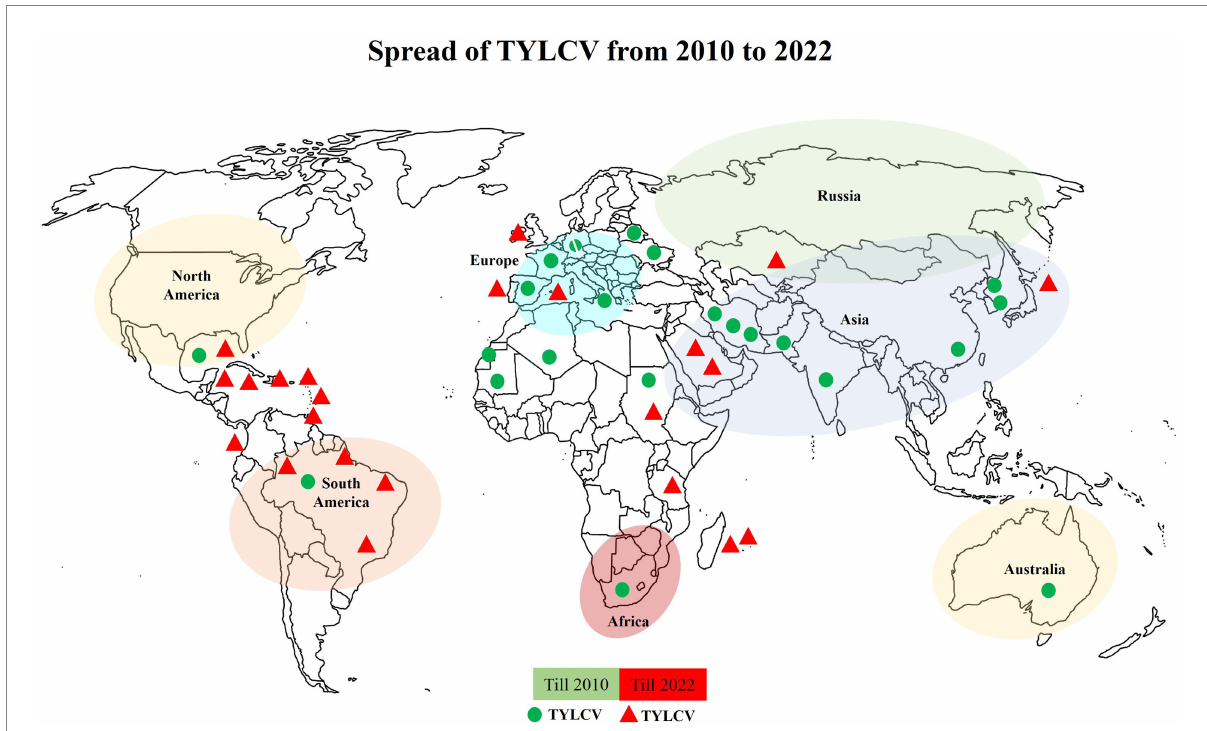
FIGURE 3 Expansion of TYLCV on the world map. Possible infected countries are highlighted in two different ways. Green dots indicate the infected countries till 2010, while red triangles indicate the expansion of this virus into new